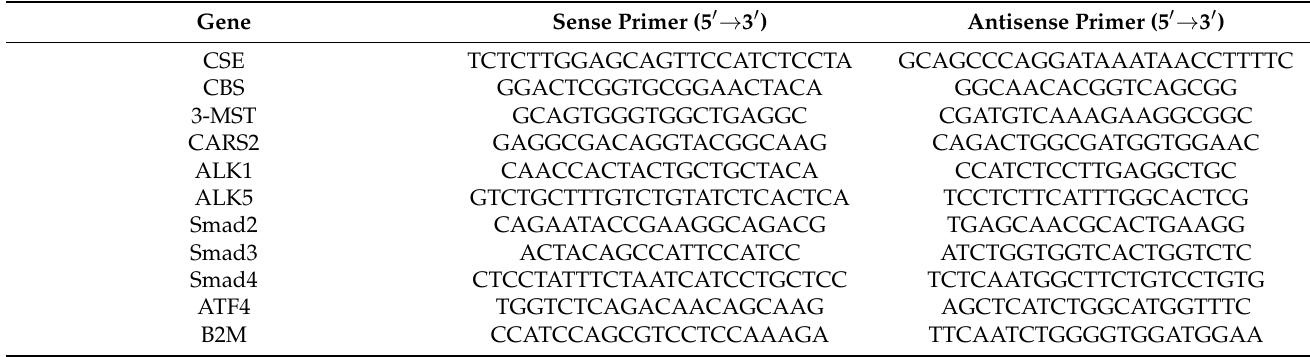
Table 2. Sequences of bovine gene-specific sense and antisense